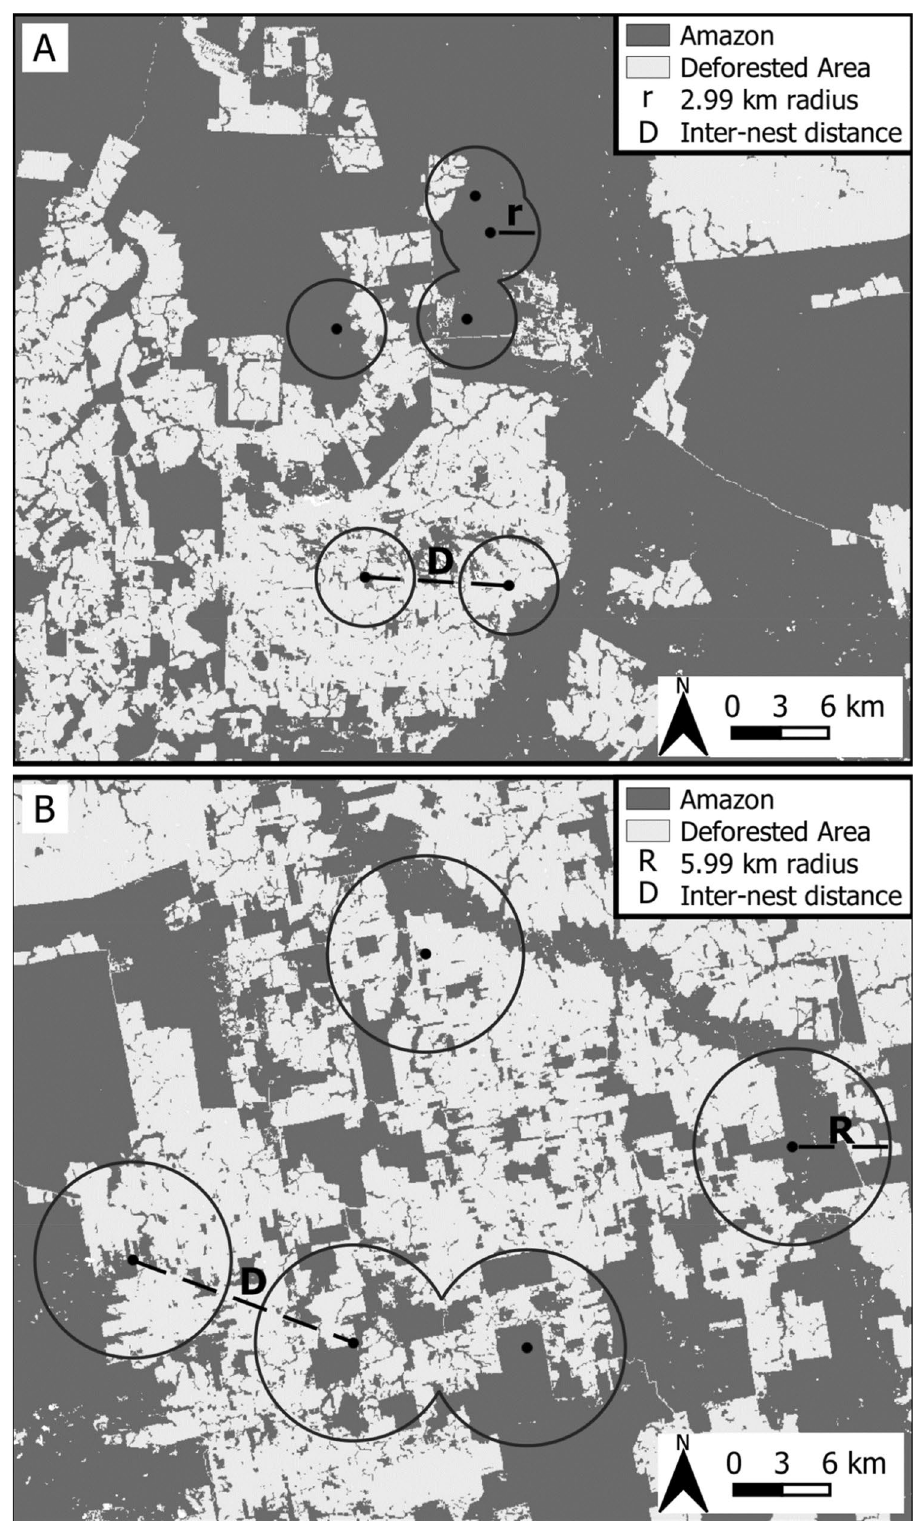
Figure 4. Examples of the spatial distribution of active breeding nests. Nest density was calculated by the Maximum Packed Nest Density (MPND) method. Distances to the nearest neighbouring nest were 2.99 km to 5.90 km depending on the nest cluster identity, which we used to calculate the 3-km and 6-km landscape buffers. The two southernmost nests in cluster A are the ones excluded for sitting in riparian forests (QGIS V.3.16; https:// www. qgis.